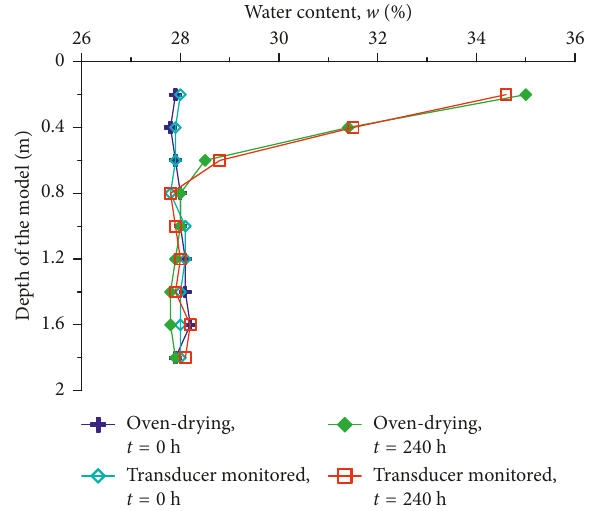
Figure 6: Comparison of water contents obtained by the trans- ducer and oven-drying.